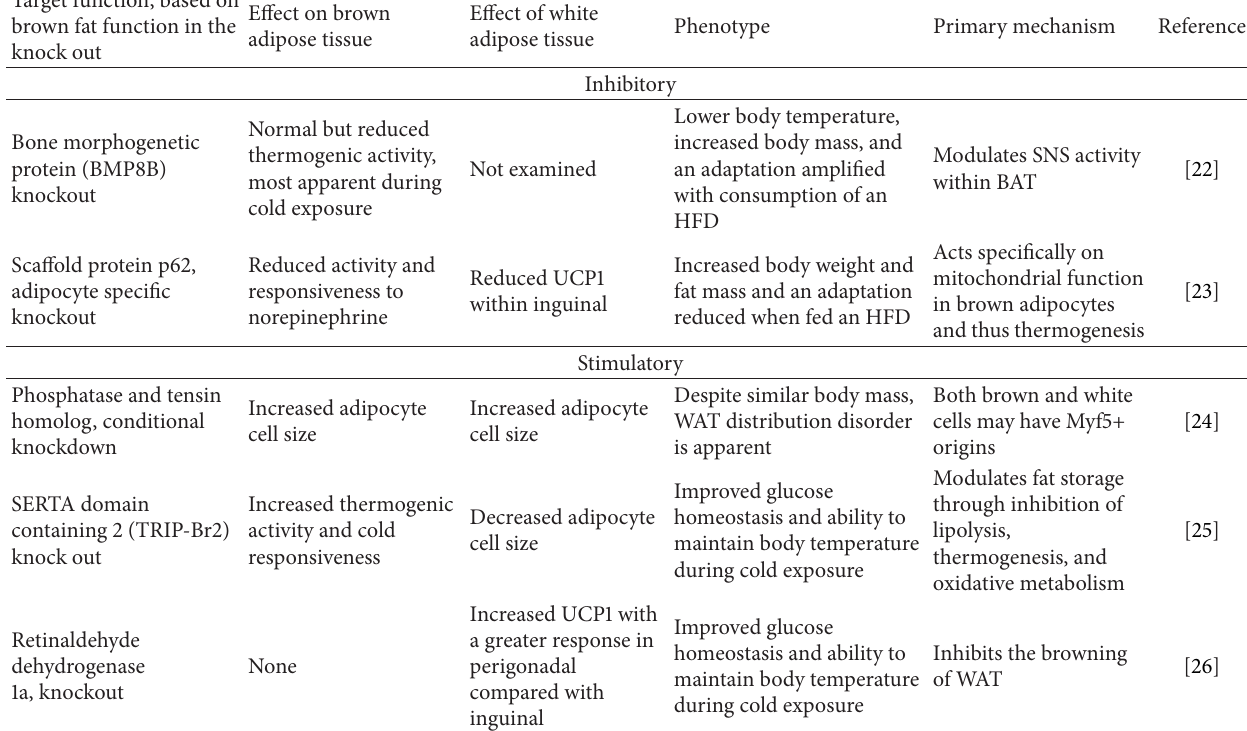
Table 2: Summary of recent targets for gene manipulation studies designed to impact on brown fat function in adult rodents maintained in a fixed thermal and photoperiodic environment.